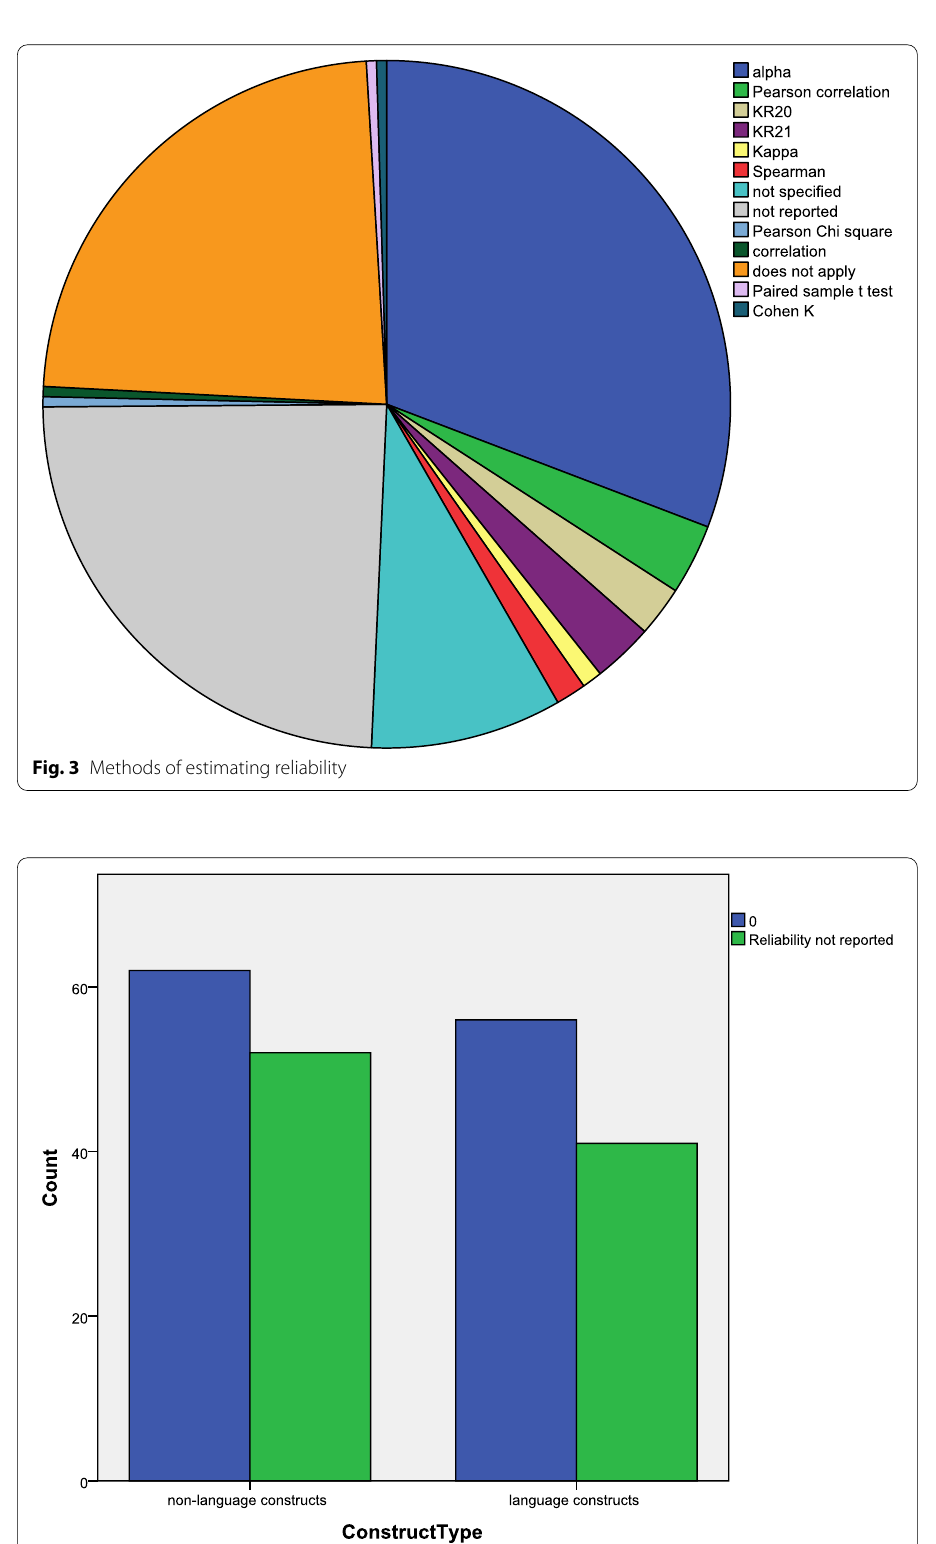
Fig. 4 Frequency of reporting reliability for language and non-language